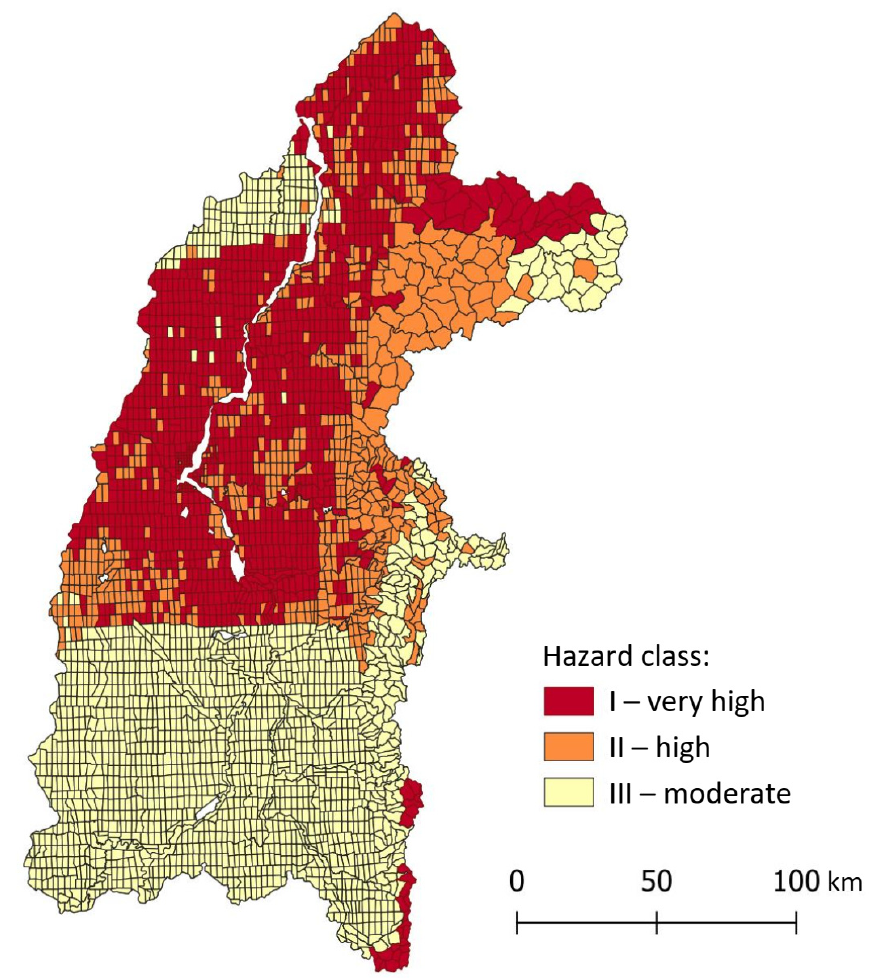
Figure 13. The forecasting results in the Kazachinsk-Lena forestry.